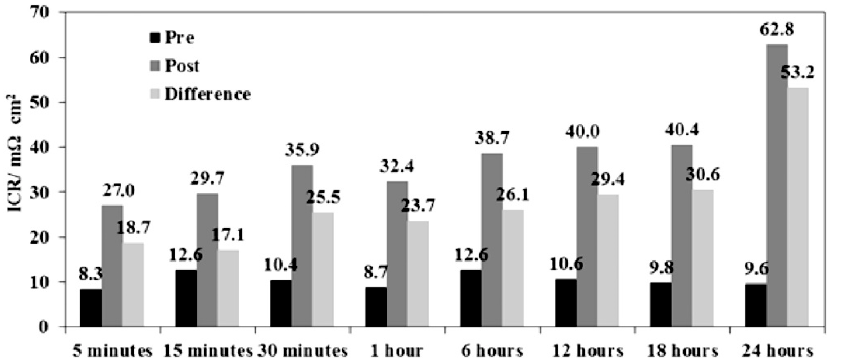
Figure 21. Effect of exposure time on contact resistance values for TiN coating on 316L steel before and after potentiostatic test in 1 mM H 2 SO 4 . Reprinted from [23] copyright (2015), with permission from Elsevier.